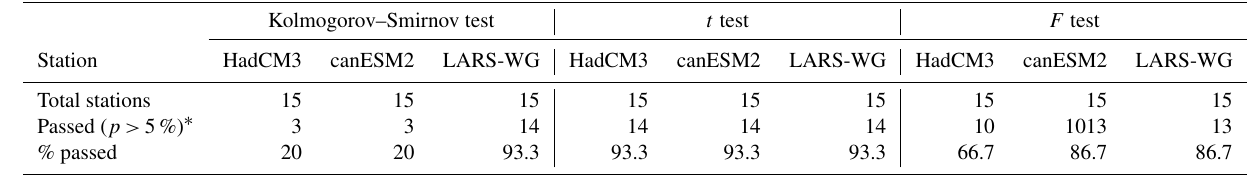
Table 7. Kolmogorov–Smirnov, t and F tests during the baseline period (1984–2011) for qualitative measures. Kolmogorov–Smirnov test t